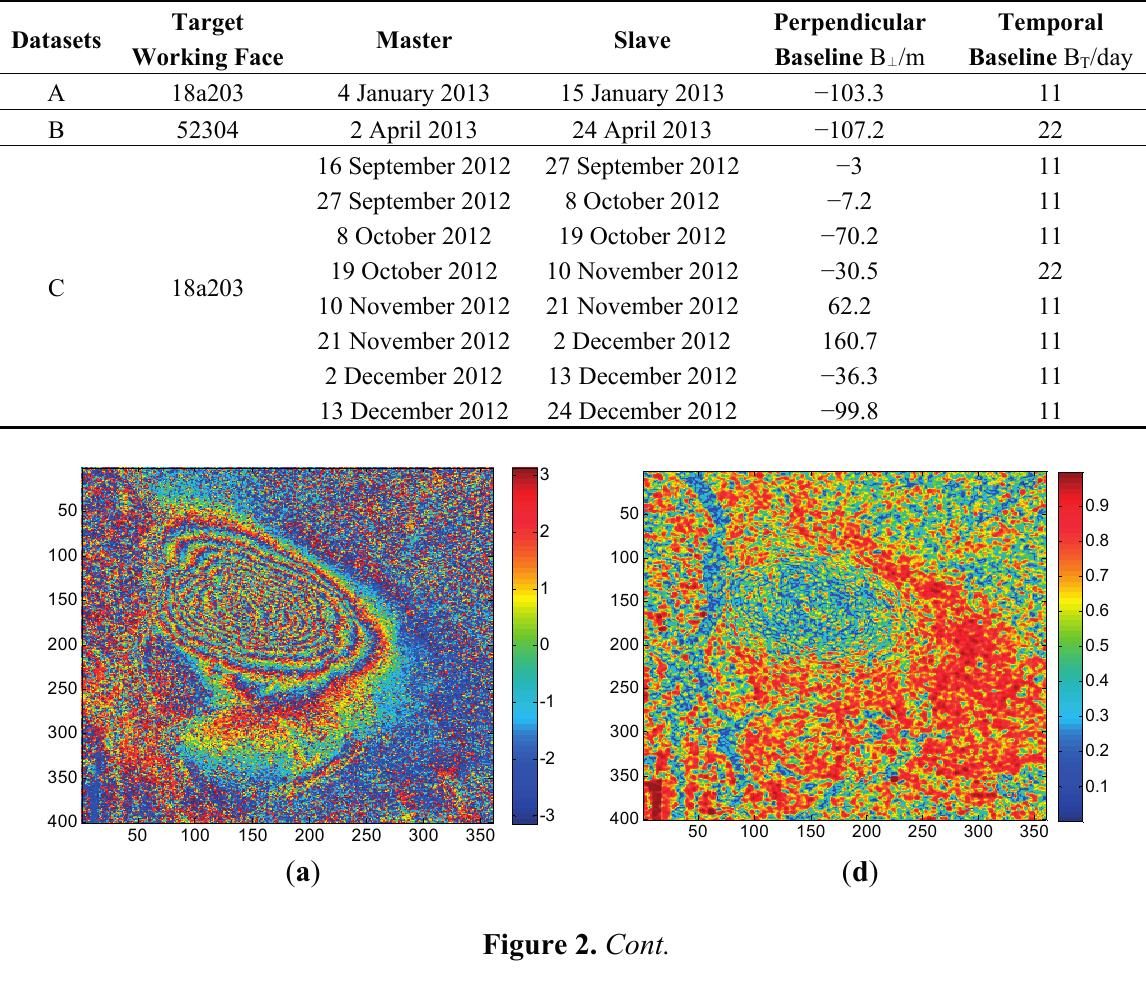
Table 2. Specifications of interferometry combination for